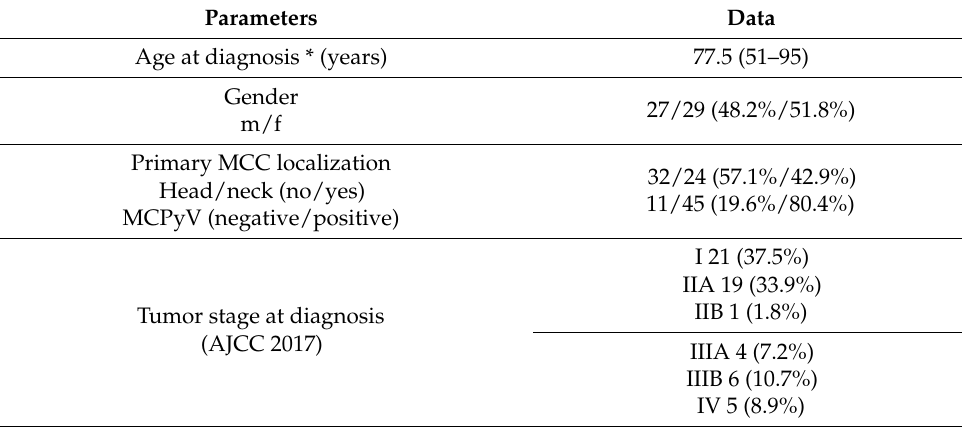
Table 1. Clinical characteristics and results of the mismatch repair protein analysis in patients with Merkel cell carcinoma (MCC, n =